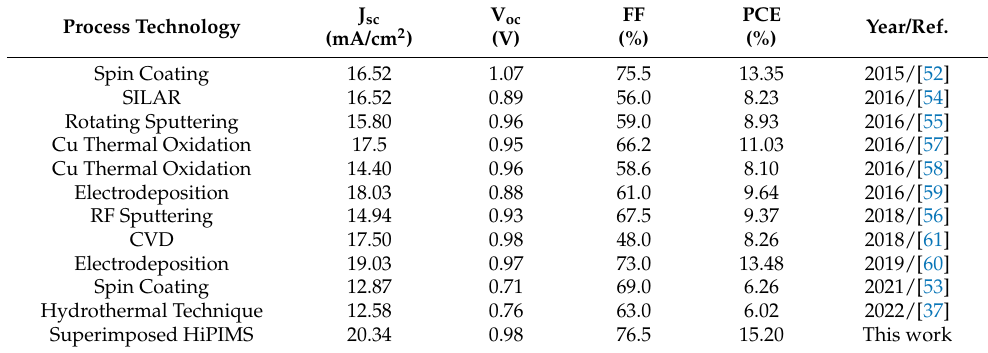
Table 2. Performances of Cu 2 O HTLs in PSCs prepared by different process technologies in the literature. Process